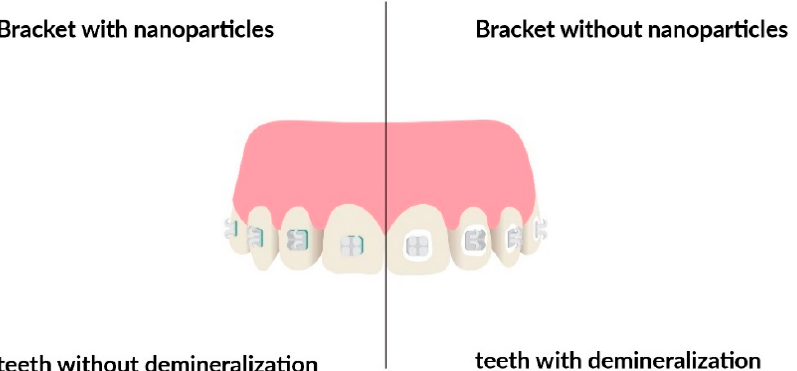
covered Figure 2. Comparison of teeth demineralization development with and without nanoparticles’ covered brackets.